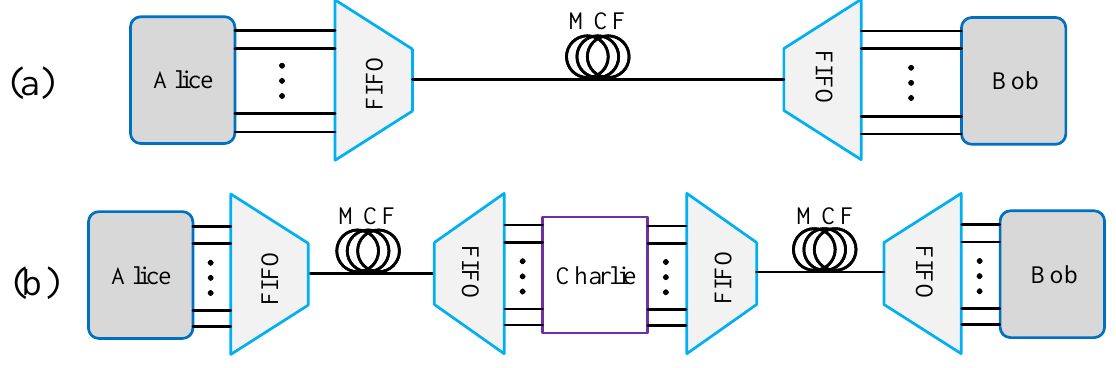
Figure 4. The MCF-based CVQKD protocols. ( a ) The one-way or two-way CVQKD protocol. ( b ) The MDI CVQKD protocol. FIFO: